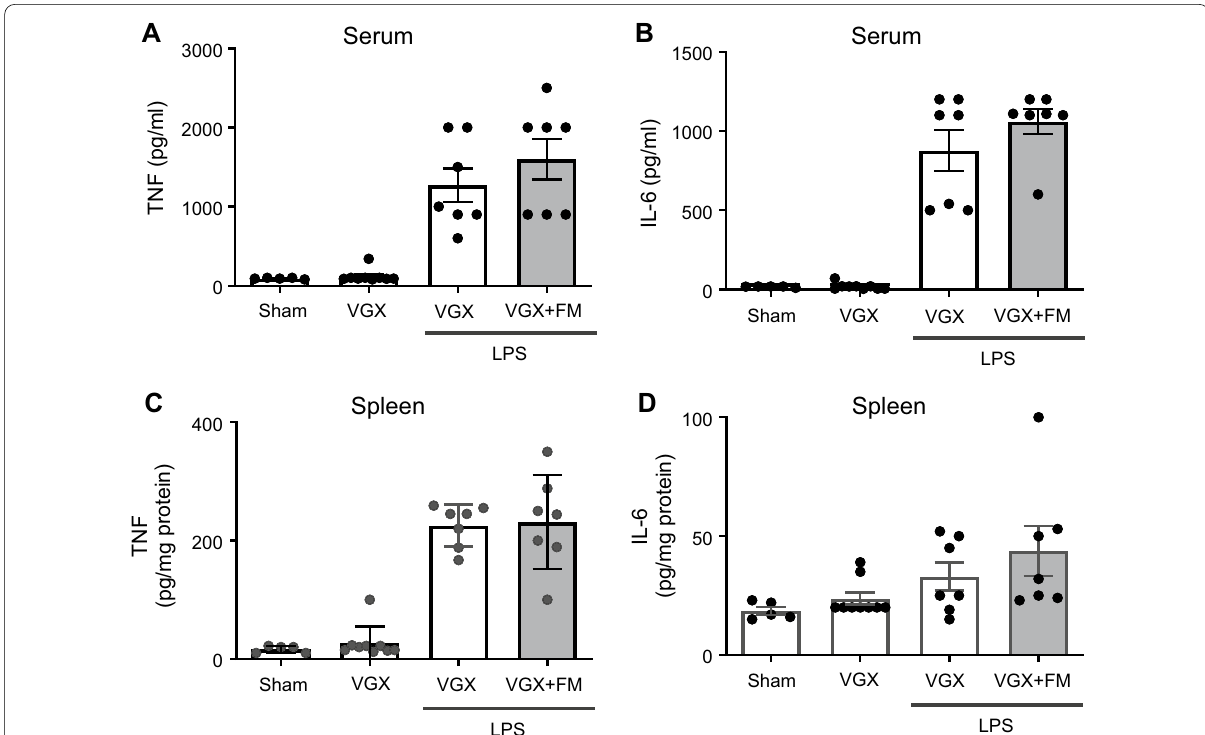
Fig. 5 The suppressive effects of famotidine on LPS-induced pro-inflammatory cytokine release were abrogated in bilateral sub-diaphragm vagotomized mice. A – D Male C57BL/6 mice had vagotomy (VGX; bilateral sub-diaphragmatic, with transgastric pyloric dilation to reduce stomach distension) and recovered for 7 days. Mice received famotidine (4 mg/kg) IP 30 min prior to LPS (IP, 7 mg/kg). Mice were euthanized 2.5 h later, serum and spleen TNF and IL-6 were measured. N 5 for normal; 7 per group for =